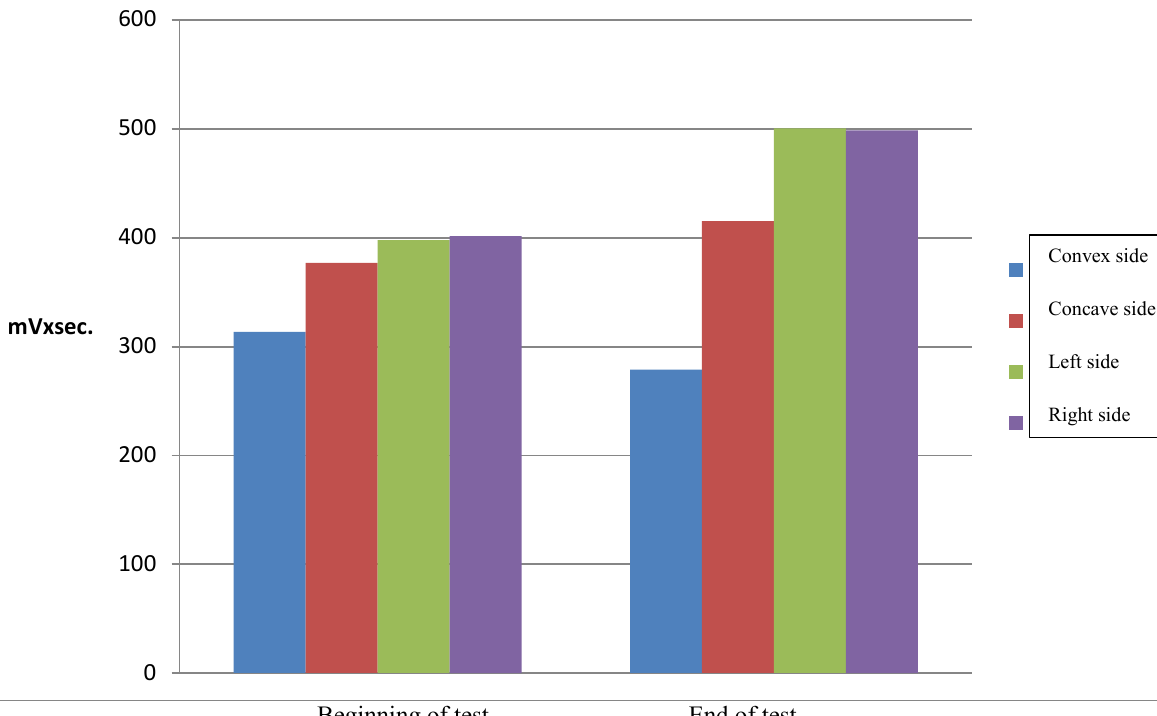
Fig.1. Indicators of back muscles’ electric activity in experimental and control groups during static test In control group there was a tendency to increasing of total electric activity of back muscles: from 397.6±36.7 mV  sec. (beginning of static loads) to 500.1±56.4 mV  sec. (at the end, р  0.05). It is connected with tiredness and switching on of additional motor